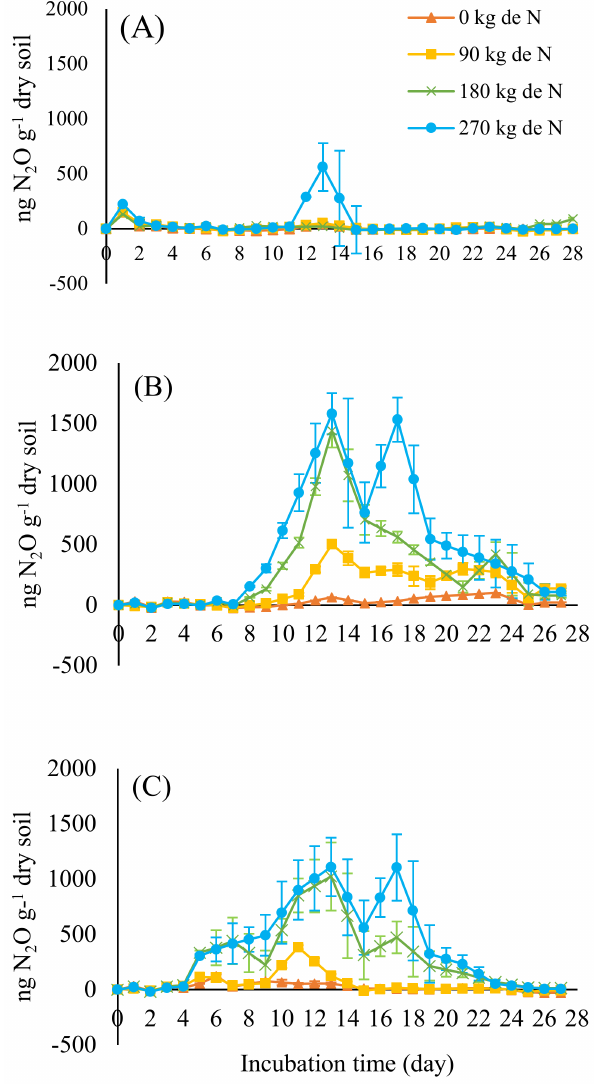
Figure 4. N 2 O fluxes (ng N 2 O g − 1 dry soil day − 1) in different land uses ( A ) forest; ( B ) pasture; ( C ) agriculture in the Brazilian Amazon, subjected to the addition of